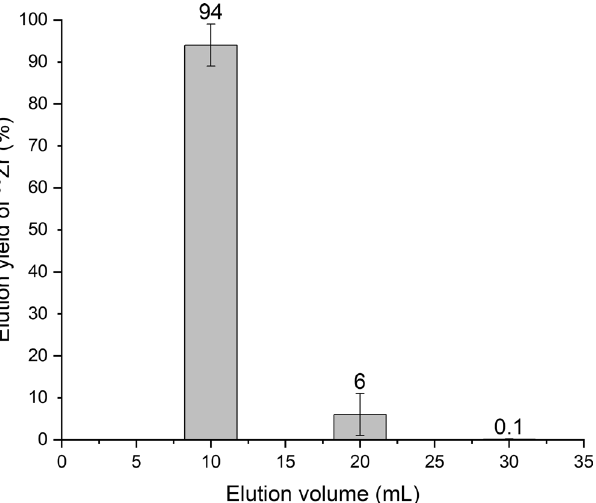
Figure 2. Elution profile for 88 Zr on a hydroxamate column (2 g). Error bars correspond to 1σ standard deviation calculated from